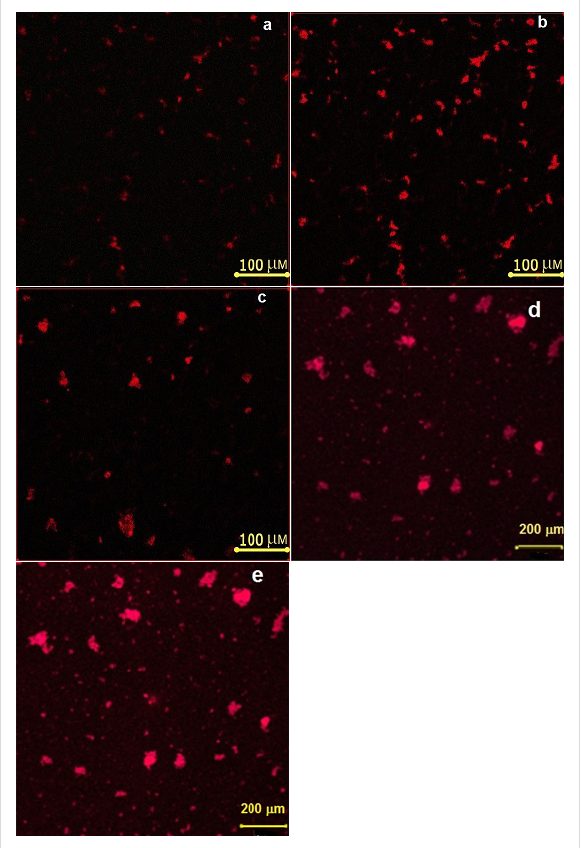
Figure 3: Photoluminescence images of CdSe/ZnS QDs in LC matrices obtained using a confocal microscope with a wavelength of 409 nm. Planar orientated LC cell (a) in the initial state, (b) at 0.25 V/ μ m (b) and (c) at 1.5 V/ μ m; vertical orientated LC cell (d) in the initial state and (e) with the maximal PL